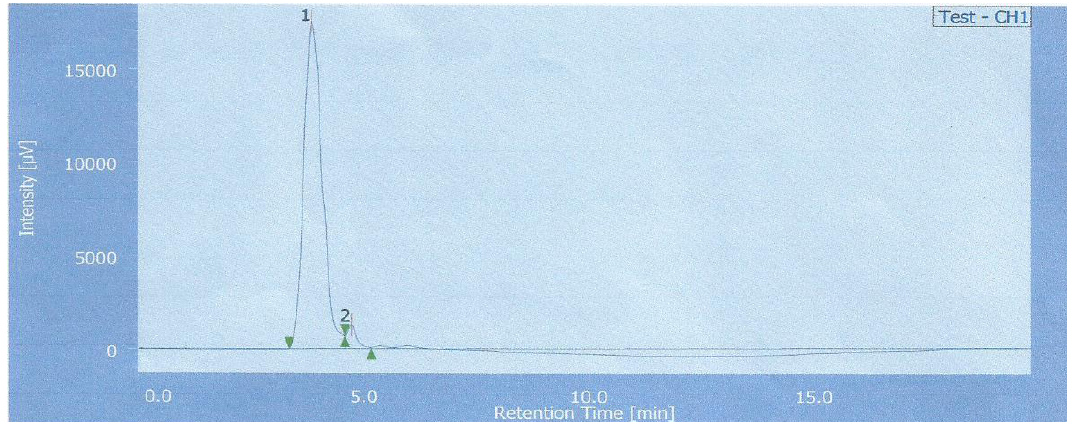
Figure (9) :- HPLC analysis of Tigogenin